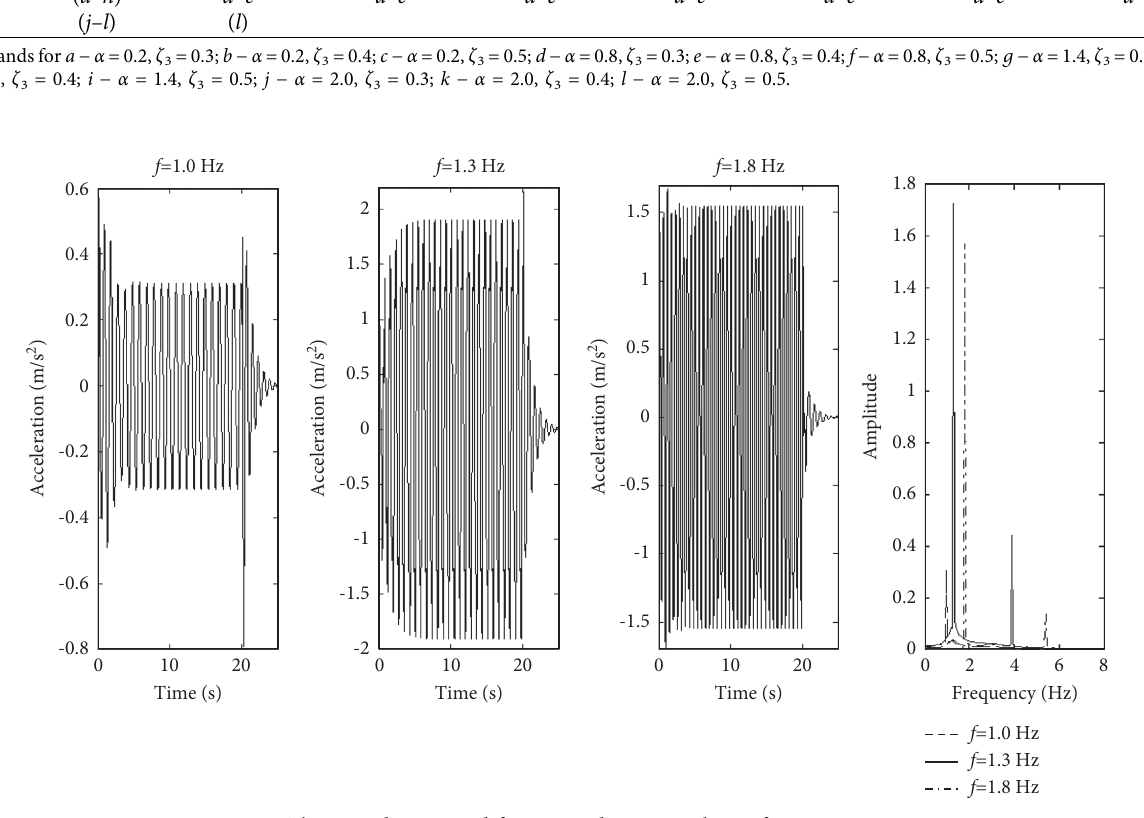
Figure 23: The time domain and frequency domain analysis of structure